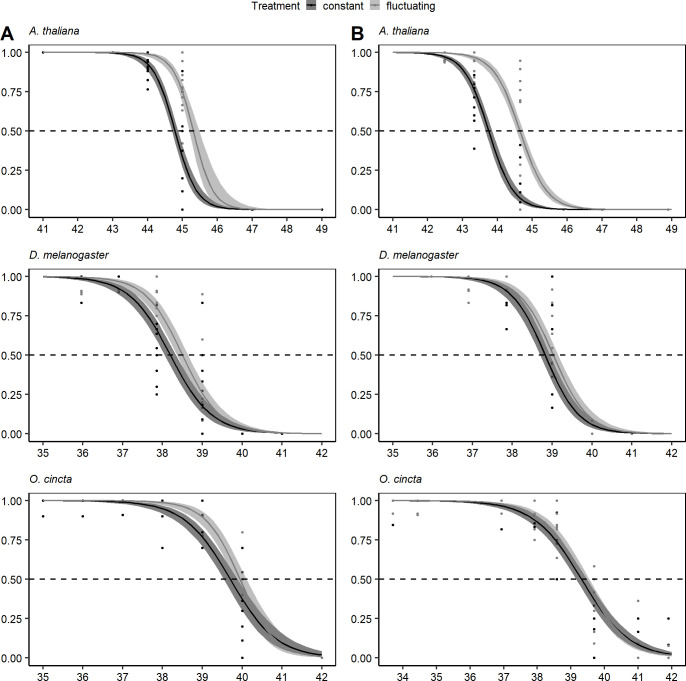
Survival proportions after heat exposure.Regression on survival proportions after exposure to heat stress at species-specific test temperatures for 1 hour for individuals acclimated to constant (black) and fluctuating (grey) thermal regimes. Panel A represents the first experimental run and panel B the second run. Individual points are survival proportion for each replicate and 95% confidence bands around the regression.